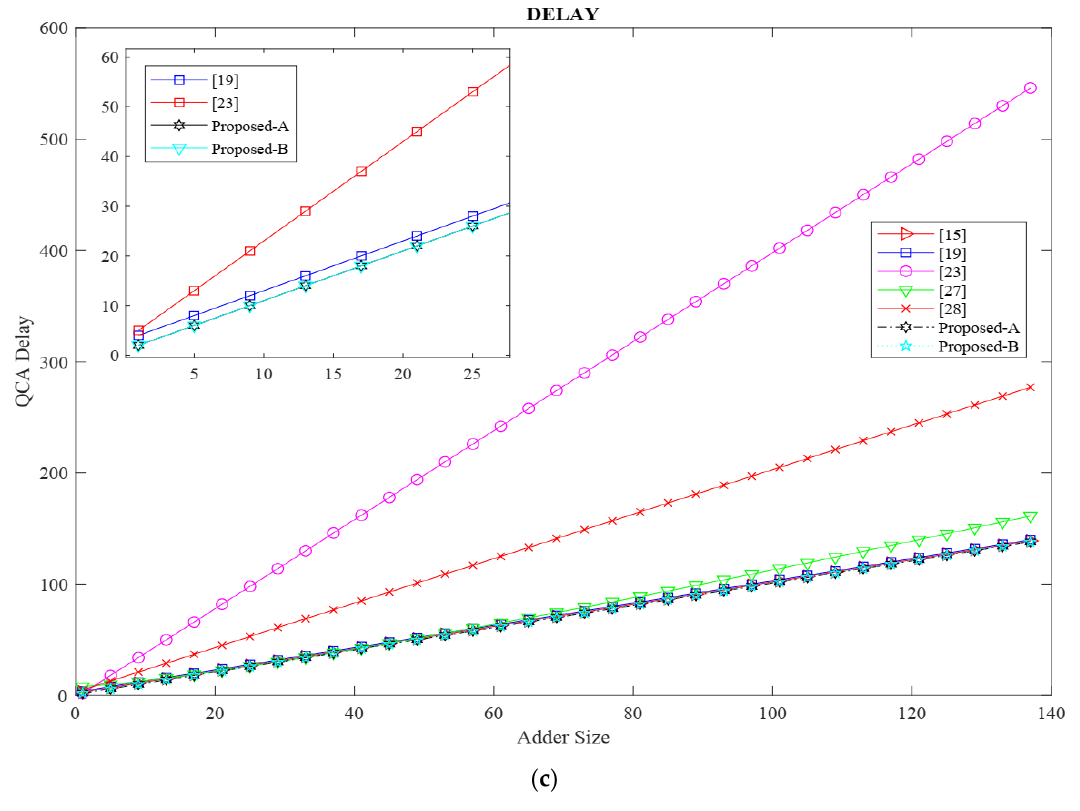
Figure 10. Comparison and evaluation of QCA adders with ( a ) cost function, ( b ) complexity and ( c ) delay criterions.